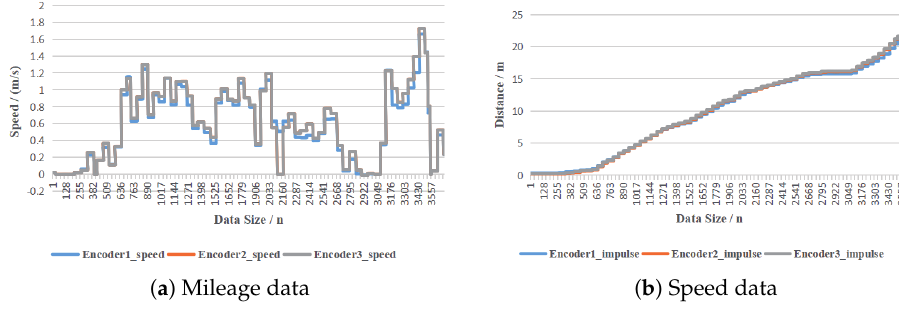
Figure 18. Data recorded by the distance measuring